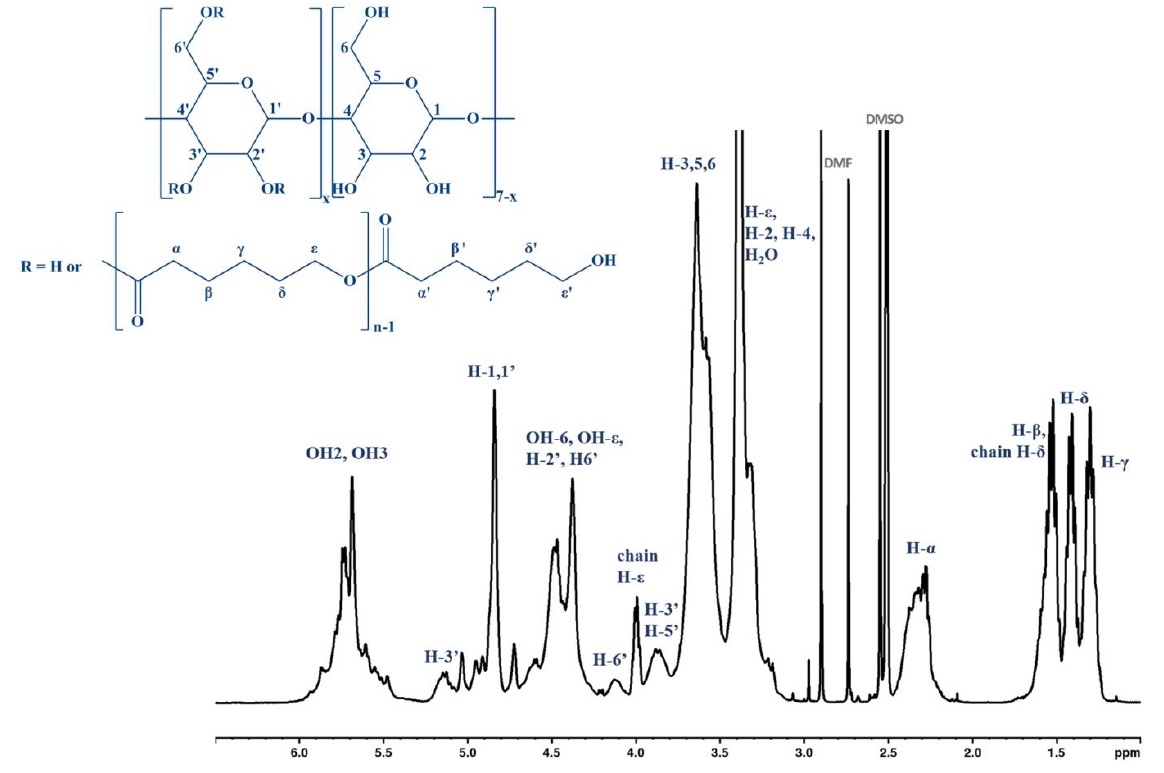
Figure 3. 1 H NMR (DMSO-d6, 400 MHz) spectrum of a typical CDCL product (synthesis #2).